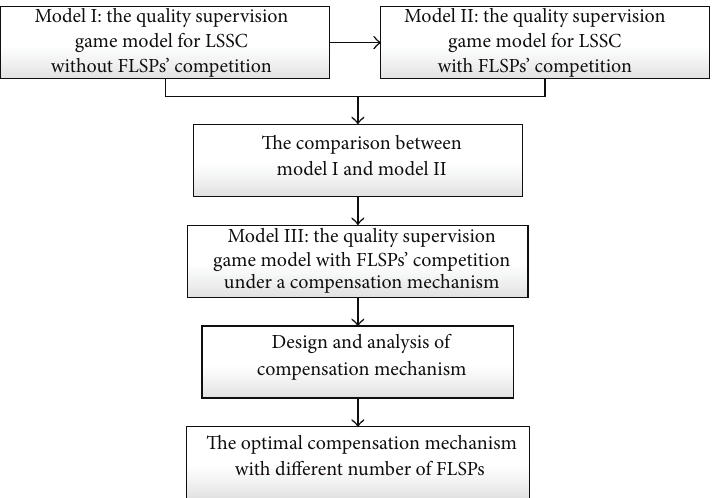
Figure 1: The research process of this